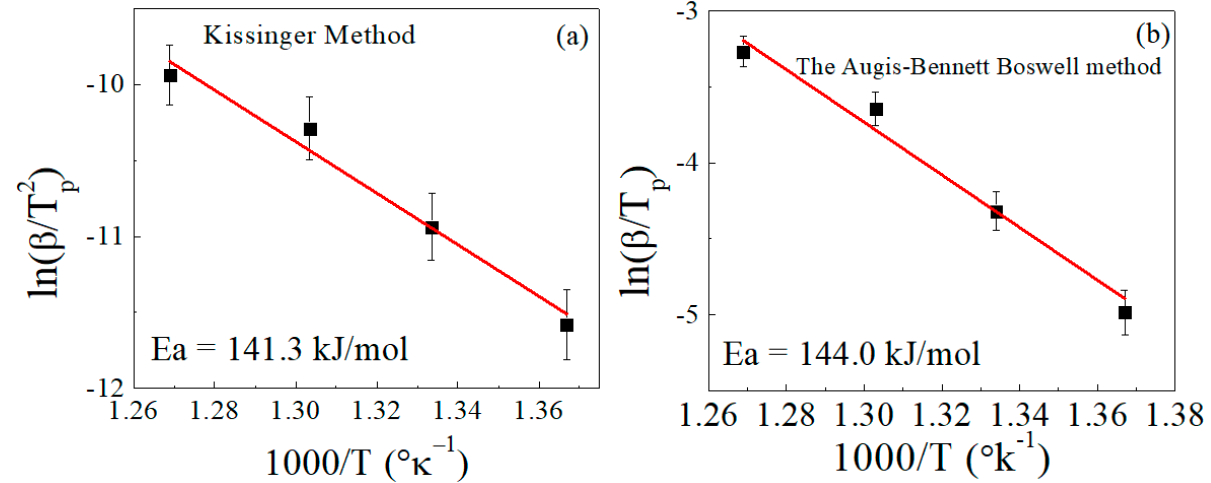
Figure 6. Determination of the activation energy (Ea) for EPDM/100 phr lead composite in ac- cordance with ( a ) the Kissinger method and ( b ) the Augis–Bennett/Boswell method. with ( a ) the Kissinger method and ( b ) the Augis–Bennett/Boswell method.